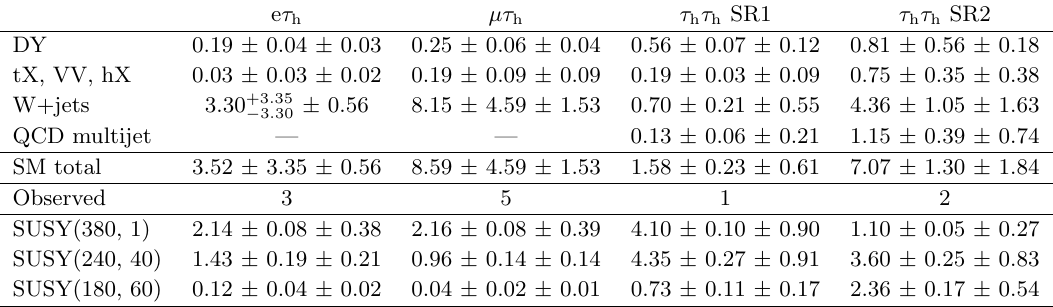
Table 7 . Data yields and background predictions with uncertainties in the four signal regions of the search. The uncertainties are reported in two parts, the statistical and systematic uncertainties, respectively. The W+jets and QCD multijet main backgrounds are derived from data as described in section 7; the abbreviation \VV" refers to diboson events. The yields for three signal points representing the low, medium, and high (cid:1) m are also shown. SUSY(X, Y) stands for a SUSY signal with m = X GeV and m = Y (cid:6) e (cid:31) 0 1 e (cid:31) 1